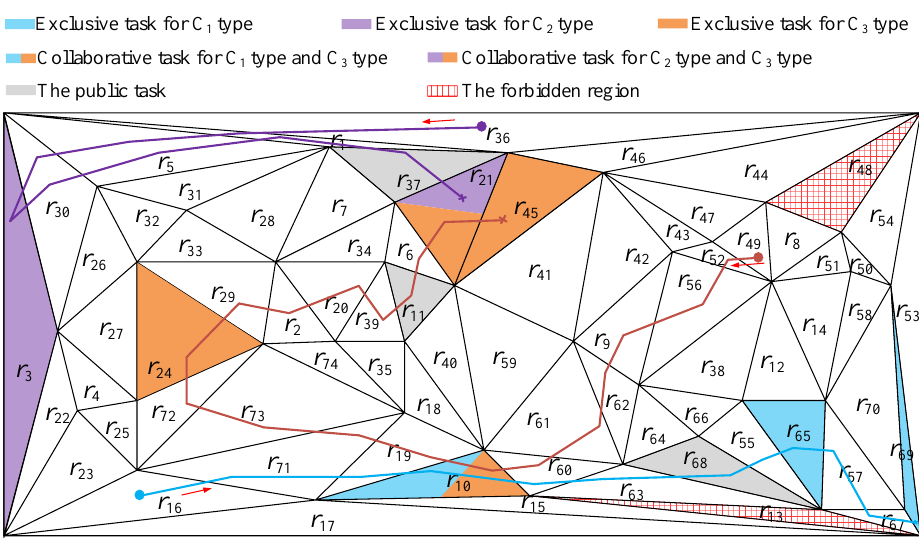
Figure 3. An MTRS with three different types of